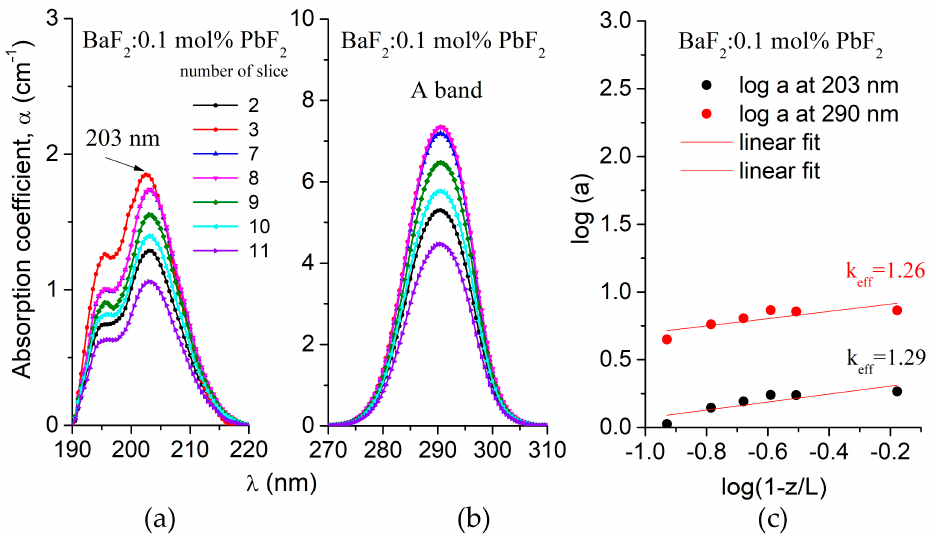
Figure 8. ( a ) Optical absorption spectra (D band) of various slices at di ff erent positions in the crystal de fi ned by g = z/L; ( b ) a band of the slices cleaved from BaF 2 :0.1 mol% PbF 2 crystal; ( c ) fi tt ing lines of log α (z) vs. log (1 − g) in order to calculate the e ff ective distribution coe ffi cient.